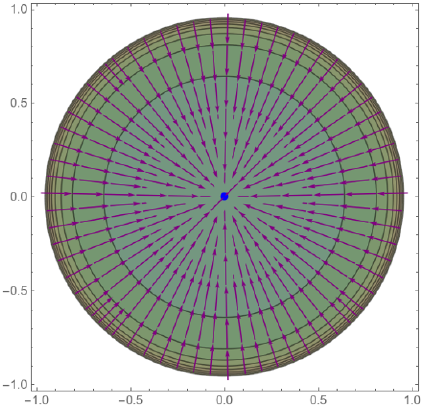
Figure 6. Contour plot of the canonical timelike Hesse function (cid:3) 1 ; 0 ; 0 . The values of the function decrease from lightest brown to darkest green. The critical point is shown as a blue dot. The gradient vector (cid:12)eld is shown in purple. This coincides with (cid:12)gure 2a, which we recall here for convenience of the